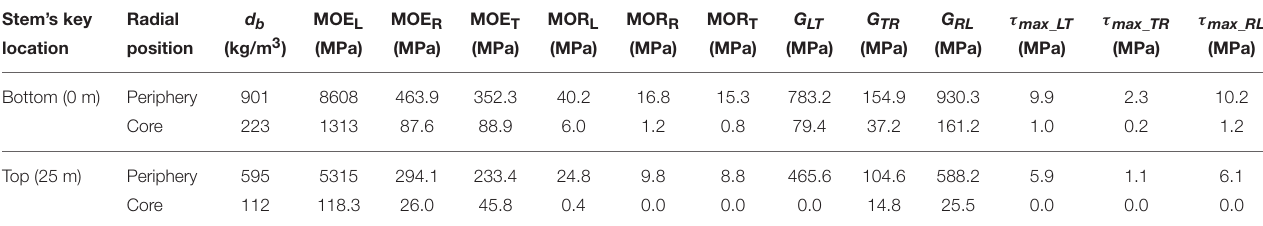
TABLE 2 | Green material properties for a characteristic senile coconut palm stem. Stem’s key Radial location Bottom (0